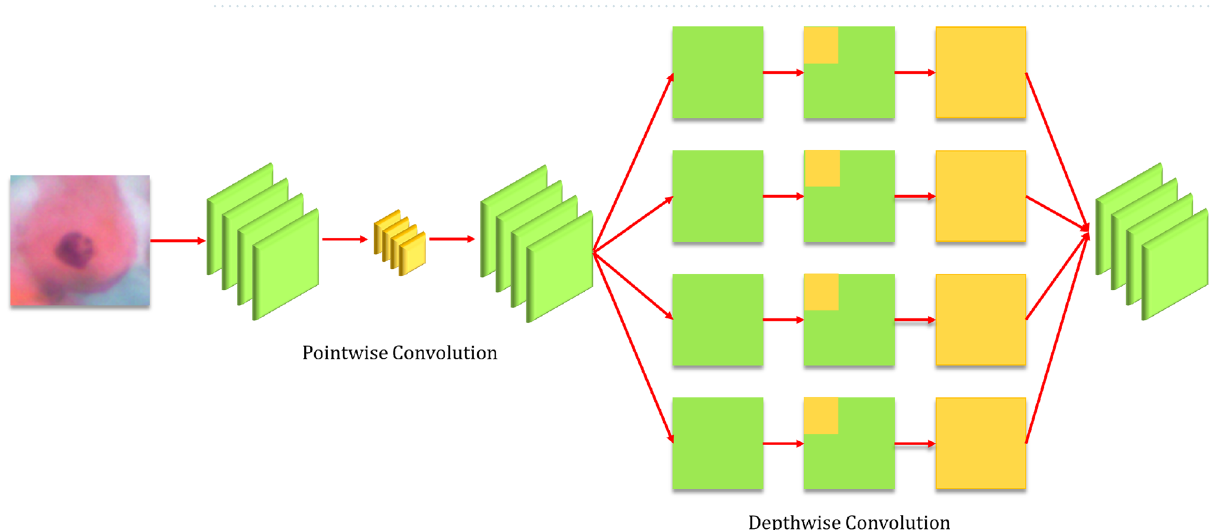
Figure 3. The architecture of the Xception model: base learner 2 (image has been made by R.K. using Google